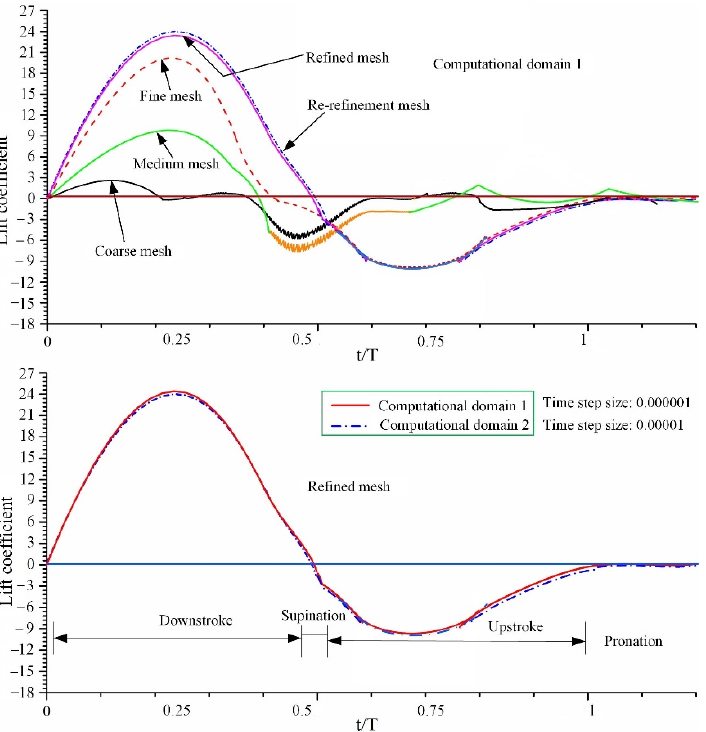
Figure 4. Comparison of lift coefficient curves between four different mesh qualities and two differ- ent computational domains. computational